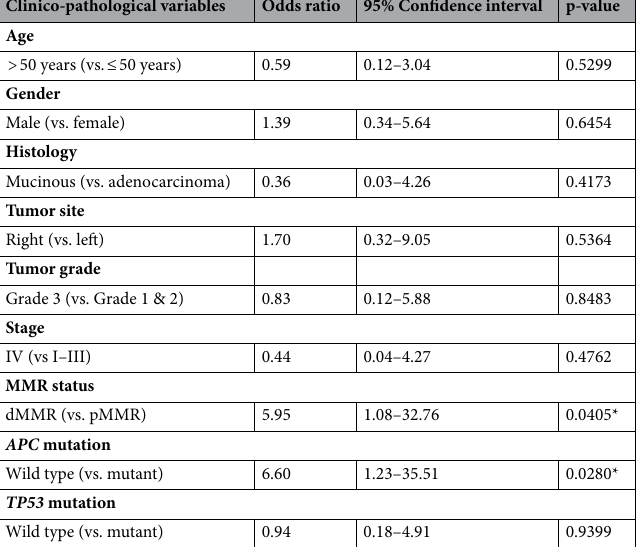
Clinico-pathological